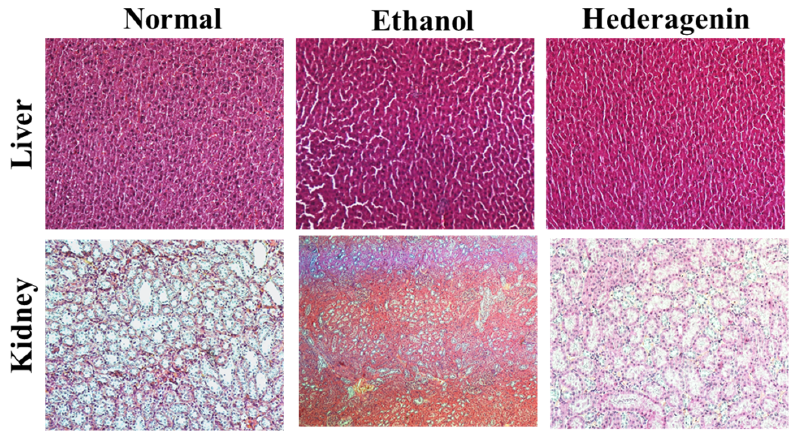
Figure 2. Histological features of representative liver and kidney sections stained with hematoxylin–eosin (H&E) after chronic ethanol consumption. Typical images were chosen from each experimental group (original magnification ×100).